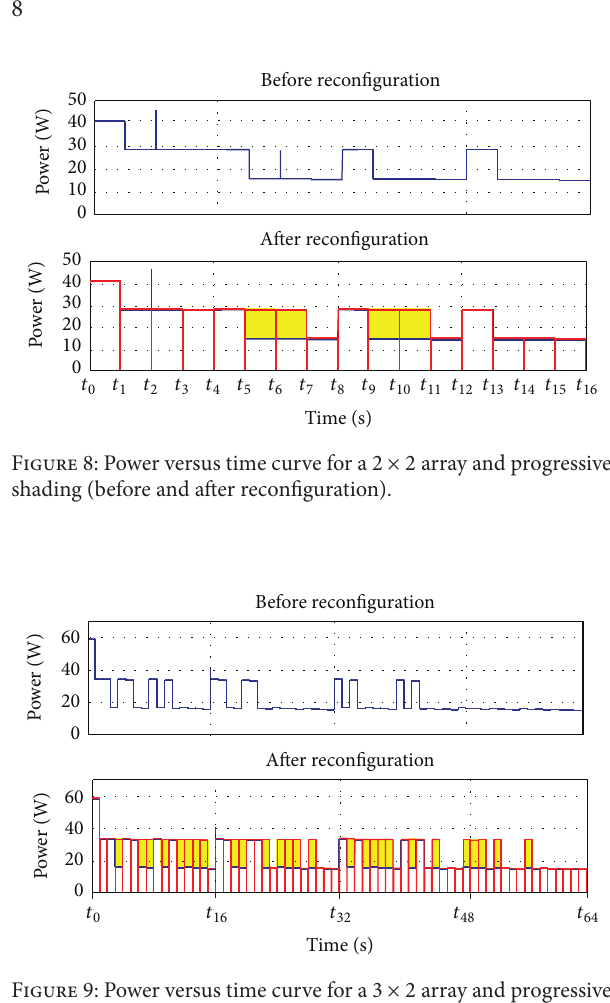
Figure 9: Power versus time curve for a 3 × 2 array and progressive shading (before and after reconfiguration).